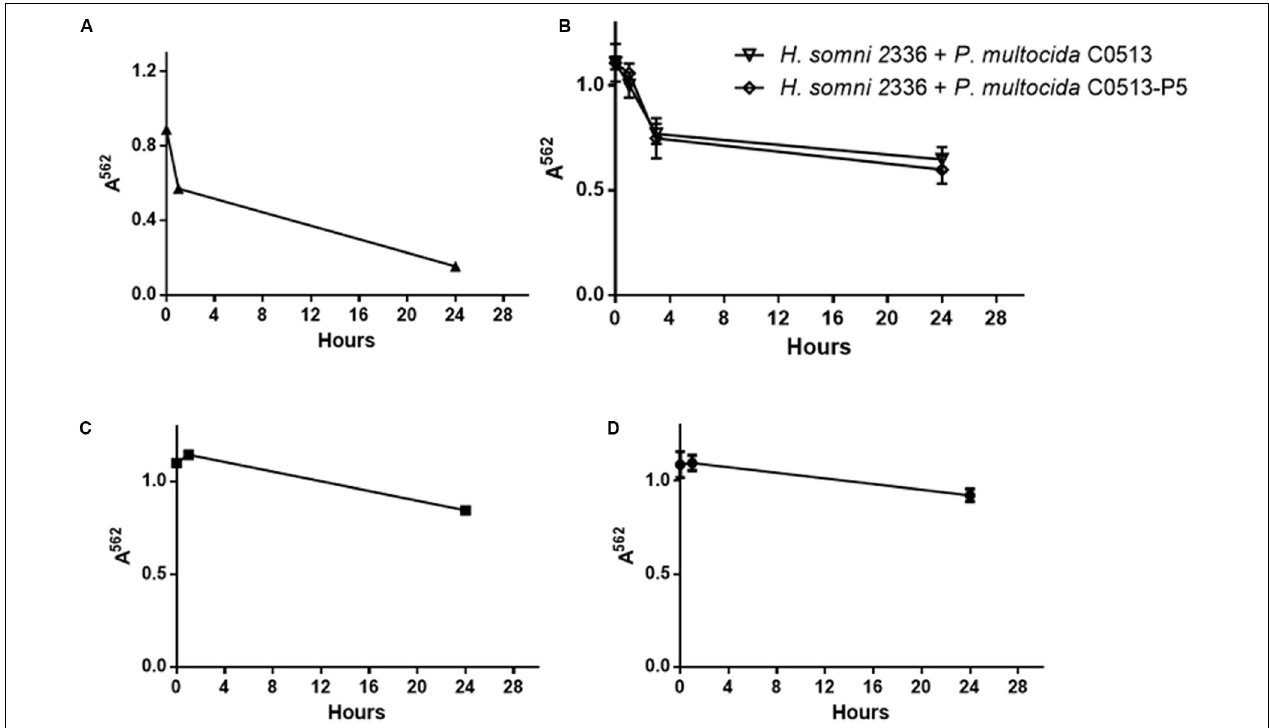
FIGURE 6 | Auto-aggregation of polymicrobial suspensions over 24 h. (A) Auto-aggregation of H. somni strain 2336 as a single species. (B) Auto-aggregation between H. somni strain 2336 and P. multocida strain C0513 or strain C0513-P5. (C) Auto-aggregation of P. multocida strain C0513-P5. (D) Auto-aggregation of P. multocida strain C0513. All experiments were performed in triplicate in three different experiments (9 datum points